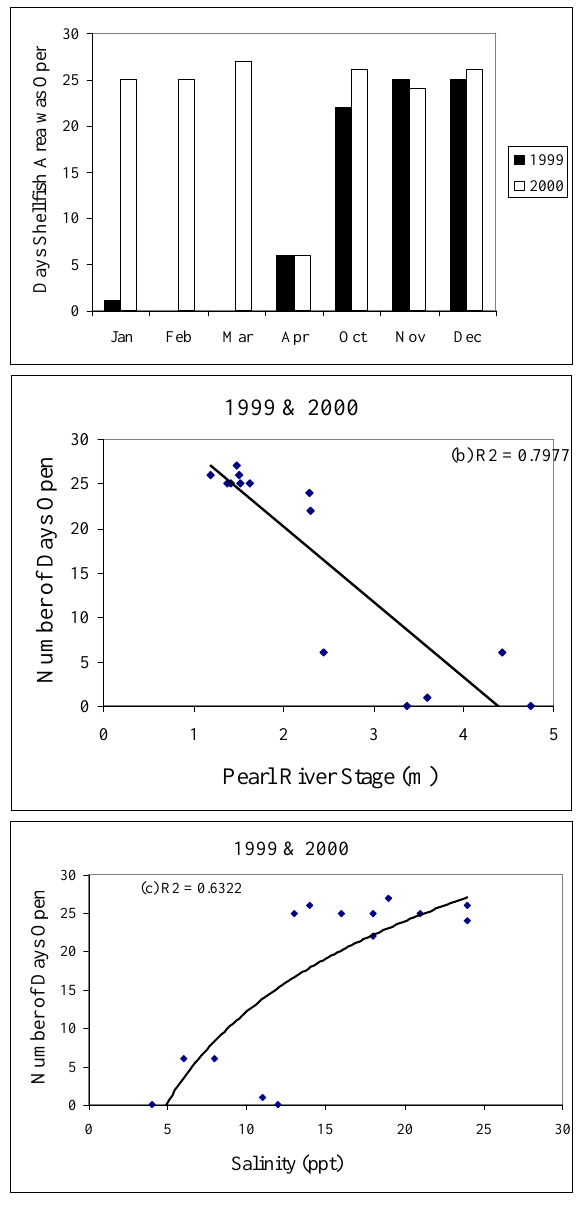
Figure 8: Number of days during which shellfish harvesting area was open during various months in 1999 and 2000 (a), and relationships between number of days during which shellfish area was open and Pearl River stage (b), and salinity